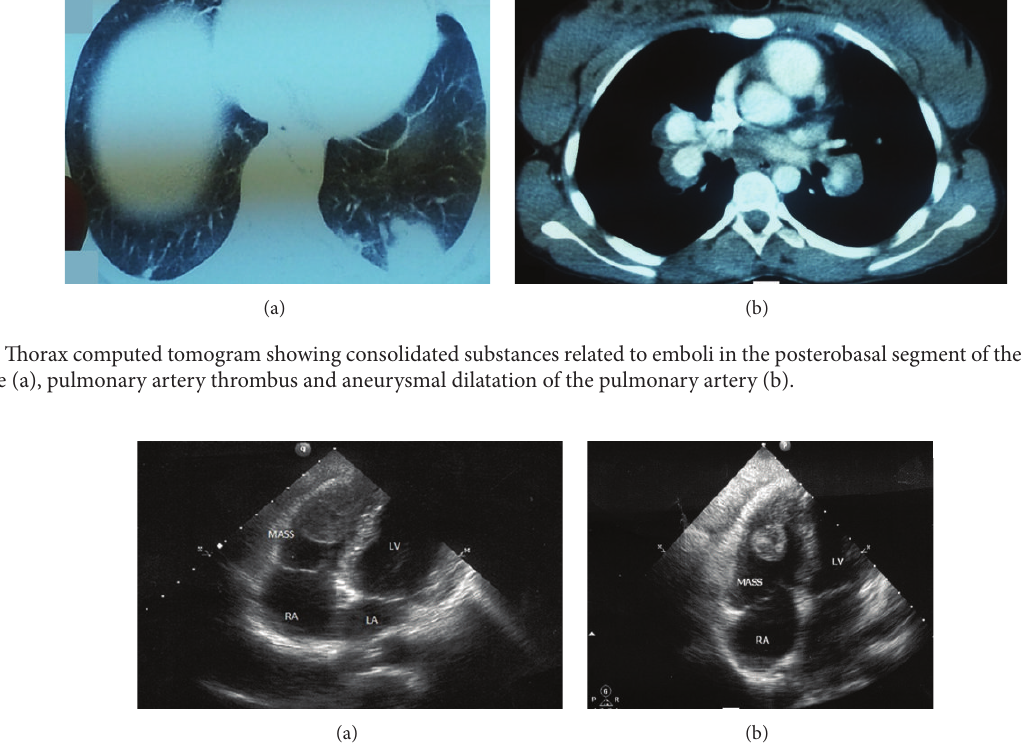
Figure 3: Thrombus in the right ventricle as seen on transthoracic echocardiogram (a), partial minimisation of the thrombus after the treatment (b).